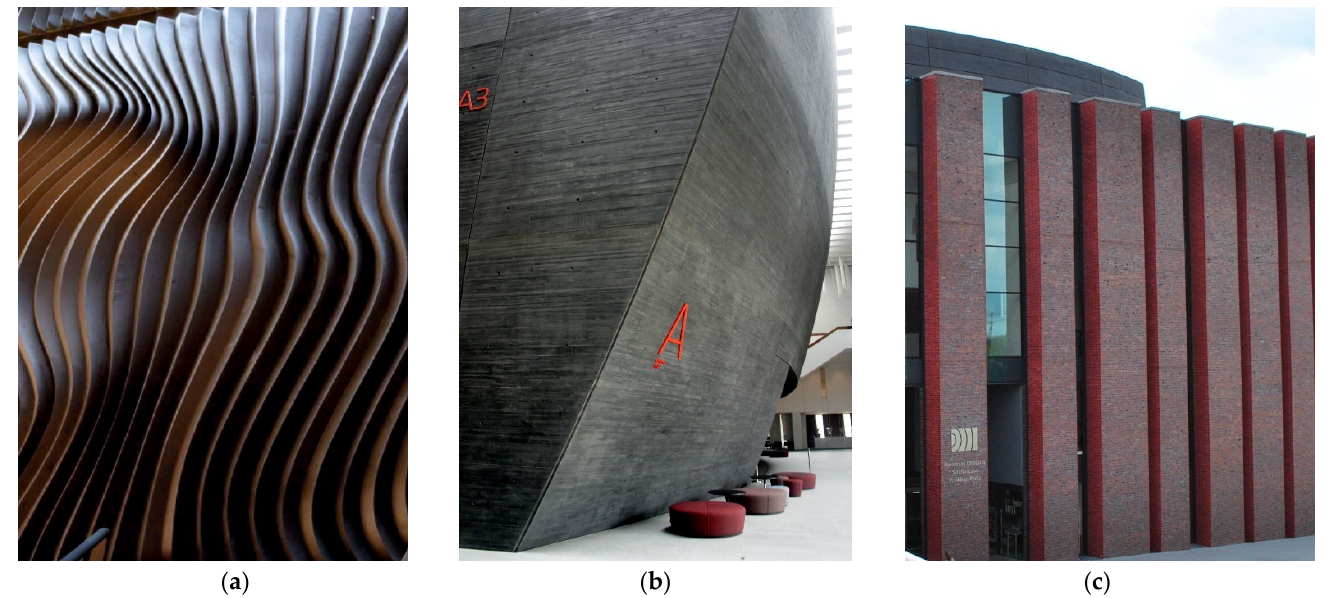
Figure 5. Polish National Radio Symphony Orchestra House, Katowice, 2014, arch. Konior Studio. ( a ) The inner precast concrete cladding of the main concert hall. Source: M. Charciarek [33]; ( b ): The inner cast concrete layered wall of the main lobby, (photo by M. Celadyn); ( c ): Main entrance. Source: https://commons.wikimedia.org/wiki/File:Katowice_05.15_NOSPR_2.JPG (accessed on 31 May 2021), photo by M. Mr ó